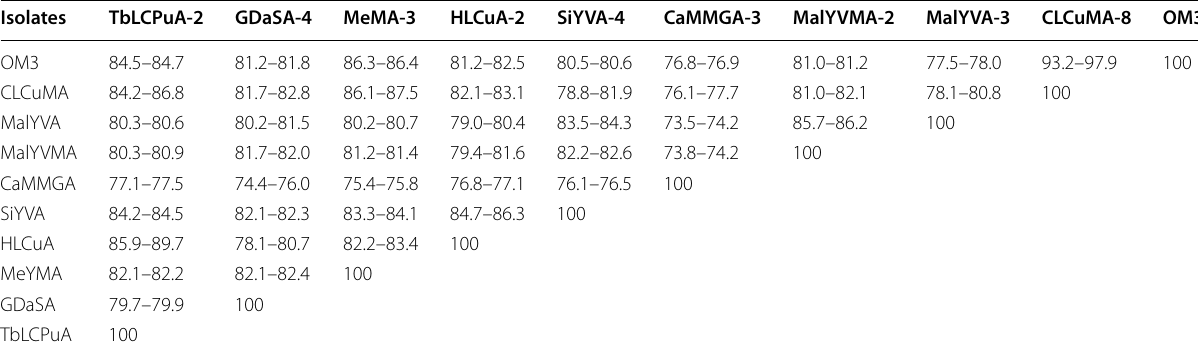
Table 3 Percentage nucleotide sequence identity between the complete sequences of alphasatellite isolate OM3 with selected alphasatellites in the